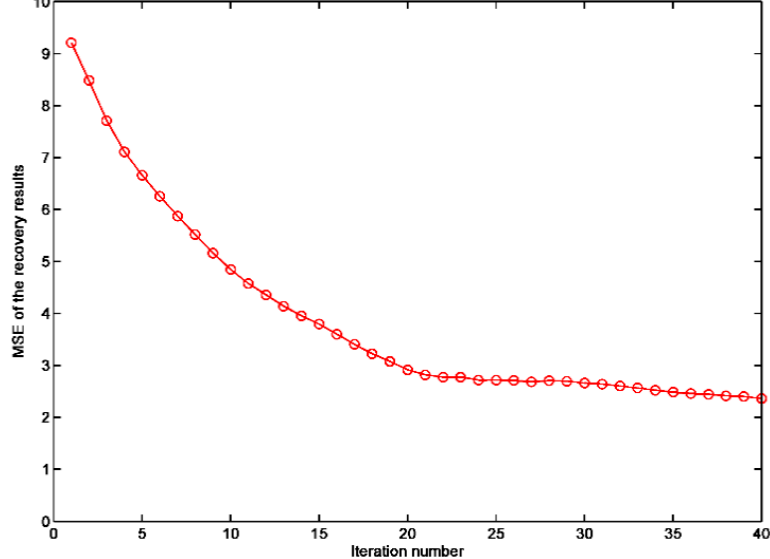
Figure 4. The MSE of the reconstruction image at different iterations when λ = 300, and the sampling number is 300. Table 1. The running time of each method.